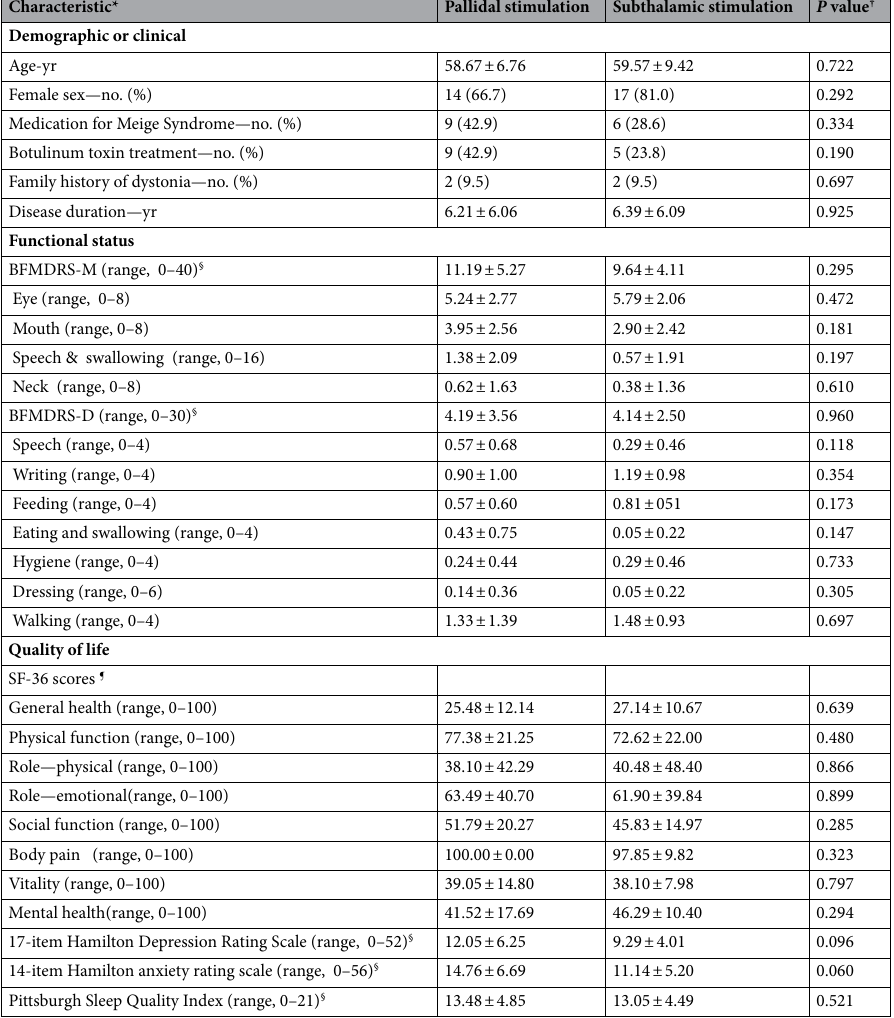
Table 1. Characteristics of the Patients at Baseline. *Plus–minus values are means ± SD. † P value s were calculated with the use of Student’s t-test or analysis of variance for continuous variables and Fisher’s exact test for categorical variables. § A higher score indicates worse functioning. ¶ A higher score indicates better